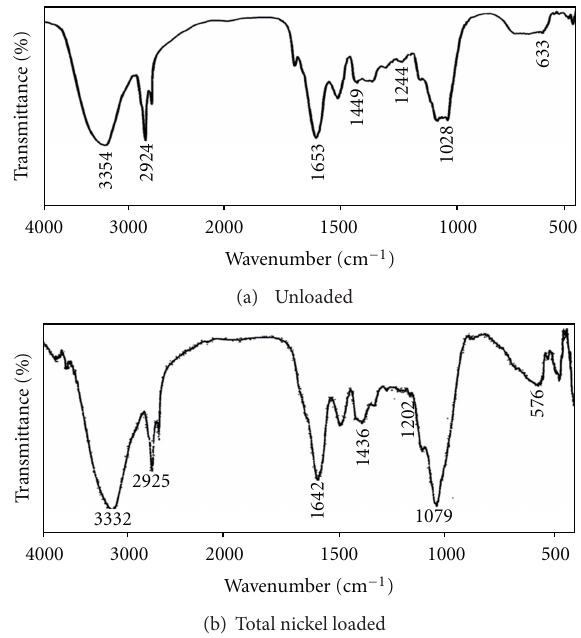
(b) Total nickel loaded F 1: FTIR spectra of T. viride biomass before adsorption (a) and aer adsorption of Nickel